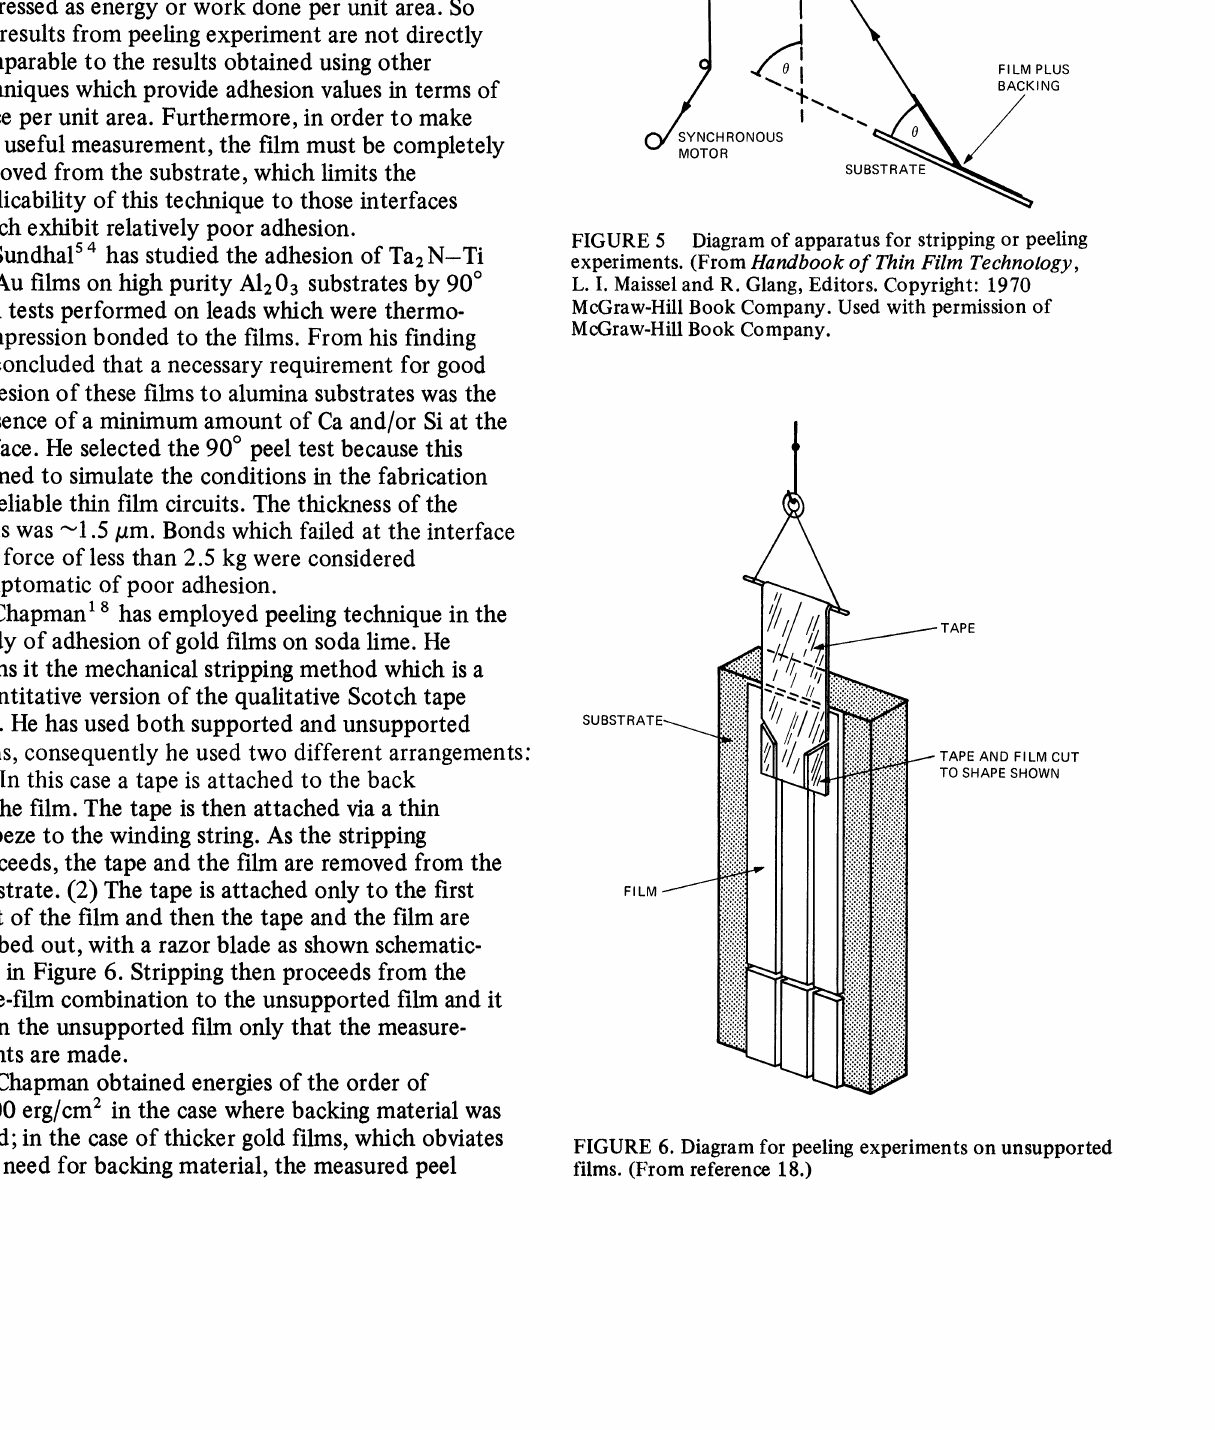
Diagram of apparatus for stripping or peeling experiments. (From Handbook of Thin Film Technology, L. I. Maissel and R. Glang, Editors. Copyright: 1970 McGraw-Hill Book Company. Used with permission of McGraw-Hill Book Company.